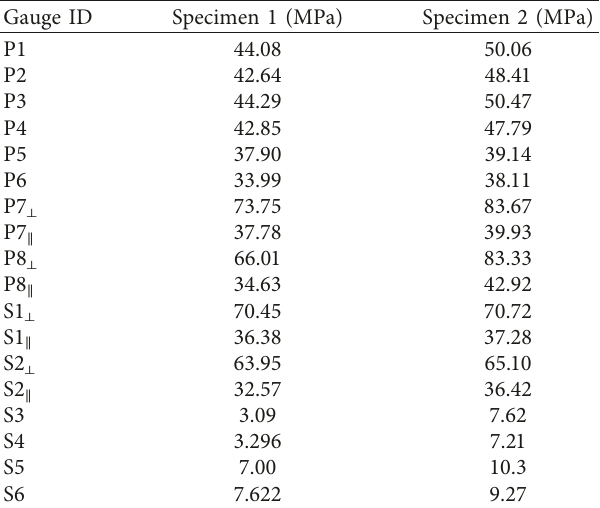
Table 3: Calculated stresses at the measuring points. Gauge